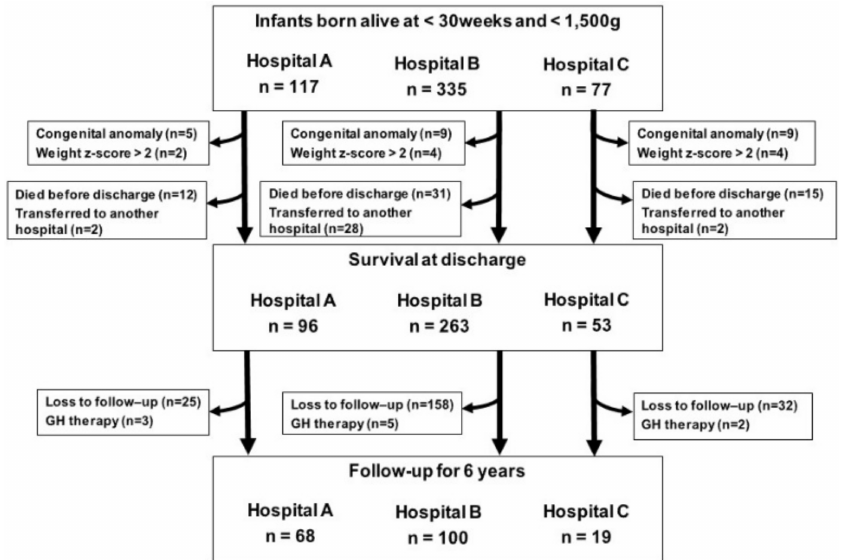
Figure 1. Flow chart of the study population. During the study period, a total of 529 VLBW infants with GA < 30 weeks were born in the NICU of three hospital, and 502 infants met the inclusion criteria at birth. We analyzed anthropometric data from 187 children up to 6 years corrected age, 44 were categorized into the 22–24 weeks group, 143 in the 25–29 weeks